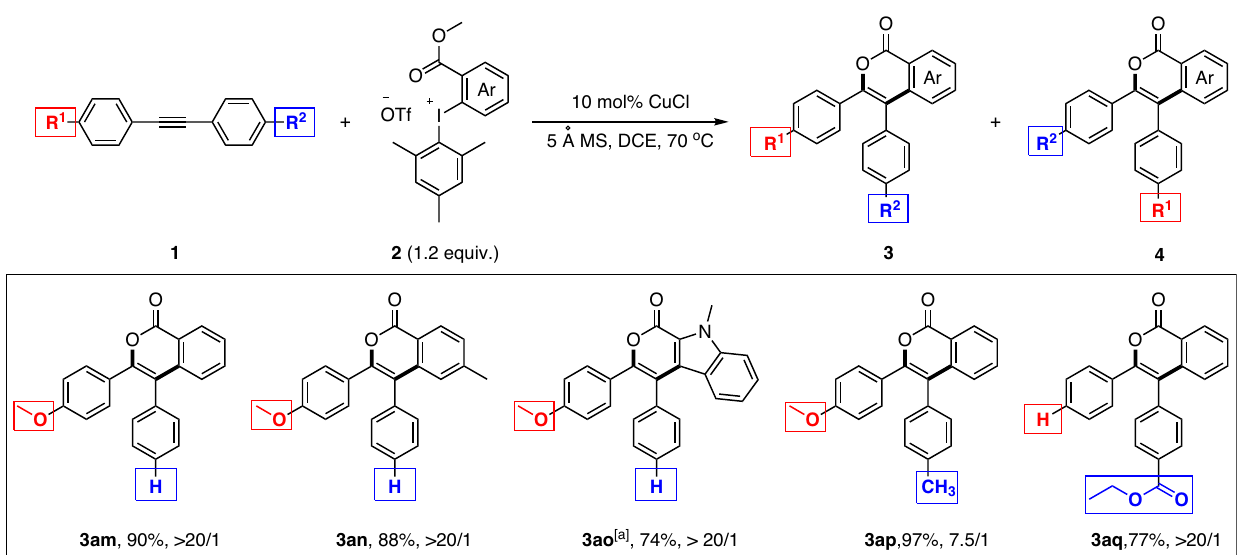
Fig. 3 Representative sterically unbiased unsymmetrical diaryl acetylenes. Reactions were performed on 0.2 mmol scale. Isolated yields were given. The ratio of 3 and 4 was determined by crude 1 H NMR. [a] Performed on 0.1 mmol